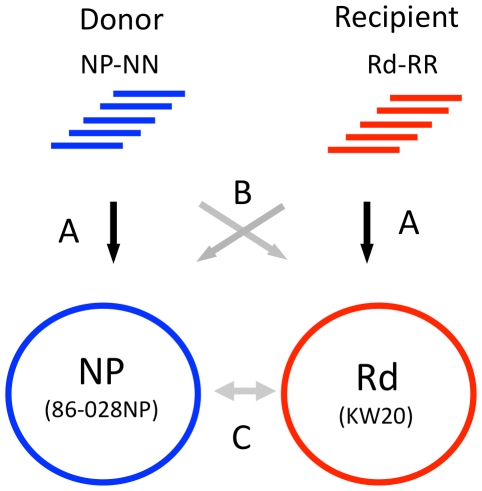
Control alignments.
Step A.
Self-alignments: Identifies intra-strain variants and ambiguous positions. Step B.
Reciprocal alignments: Identifies putative SNVs and indels between donor and recipient. Step C.
Reference alignments: Whole-genome alignment of the 86-028NP and Rd reference sequences identifies a set of SNVs for cross-validation with the self- and reciprocal-alignments.